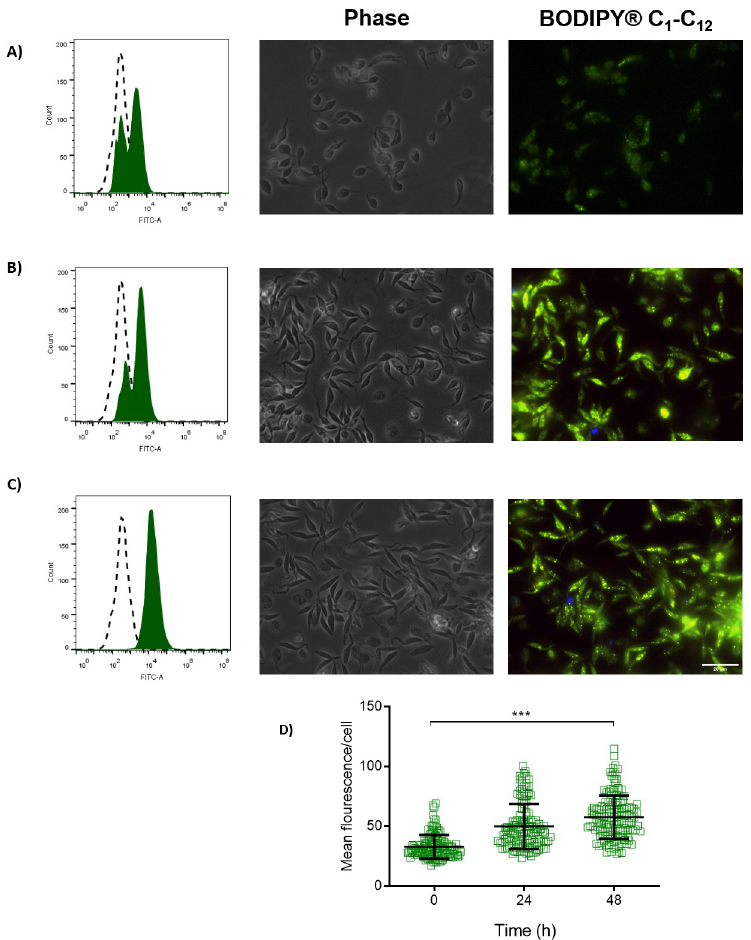
Fig 5. Flow cytometry reveals distinct patterns in fatty acid pools during epimastigote growth. The epimastigotes were treated with 1 μ M of BODIPY C 1 -C 12 (500/510) and analysed by flow cytometry and fluorescence microscopy. A) 0 h. B) 24 h. C) 48 h. In the flow cytometry histograms, dashed peaks represent unstained parasites. Green-filled peaks represent stained parasites. D) Mean fluorescence per cell. The fluorescence for each cell was calculated using ImageJ software. All the experiments were performed in triplicates. Statistical analysis was performed with one-way ANOVA followed by Tukey’s post-test p < 0.05 using the GraphPad Prism 8.0.2 software program. We represent the level of statistical significance in this figure as follows: ��� p value < 0.001; �� p value < 0.01; and � p value < 0.05. For p value > 0.05, we consider the differences not significant (ns). here (from 0.1 to 500 μ M), only the higher concentration arrested parasite proliferation (Fig 8A). Importantly, the ETO effect was manifested when the parasites reached the late exponen- tial phase (a cell density of approximately 5x10 7 mL -1 ). This result is consistent with our previ- ous findings showing that FAO (and thus CPT1 activity) acquires an important role at this point in the proliferation curve. To confirm that CPT1 is in fact a target of ETO in T . cruzi , we assayed the drug’s effect on the enzyme activity in free cell extracts. Our results showed that 500 μ M ETO diminished the CPT1 activity by almost 80% (Fig 8B). To confirm the interfer- ence of ETO with the beta-oxidation of fatty acids, parasites incubated in PBS containing 14 C-U-palmitate were treated with 500 μ M ETO to compare their production of 14 CO with 2 that of the untreated controls. Palmitate-derived CO production diminished by 80% in ETO- 2 treated cells compared to untreated parasites (Fig 8C). In addition, ETO treatment did not